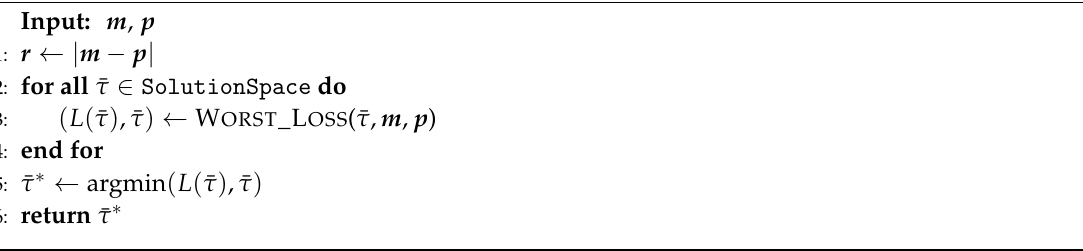
Algorithm 5 Application-Aware Detector for Equal Thresholds.